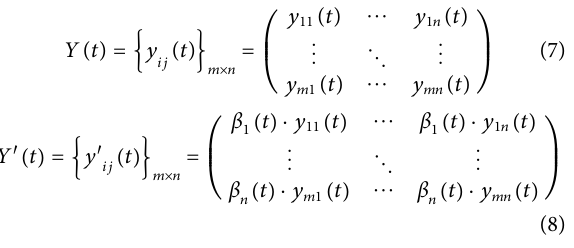
Where, E + ( t ) and E − ( t ) represent positive ideal gray correlation coef fi cient matrix and negative ideal grey correlation coef fi cient